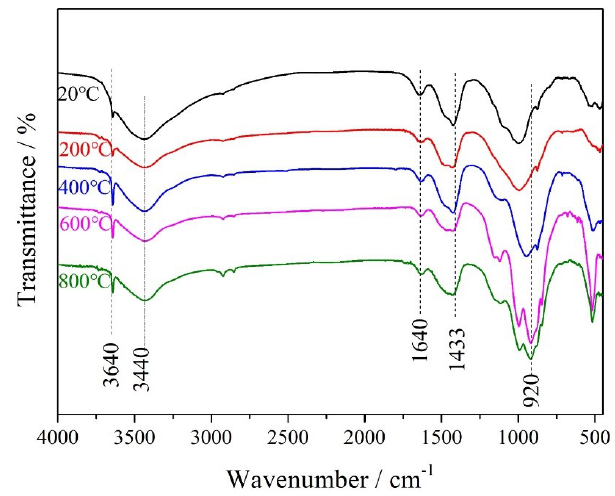
Figure 7. Fourier-transform infrared (FTIR) spectrum of cement-metakaolin pastes in KBr pellet.